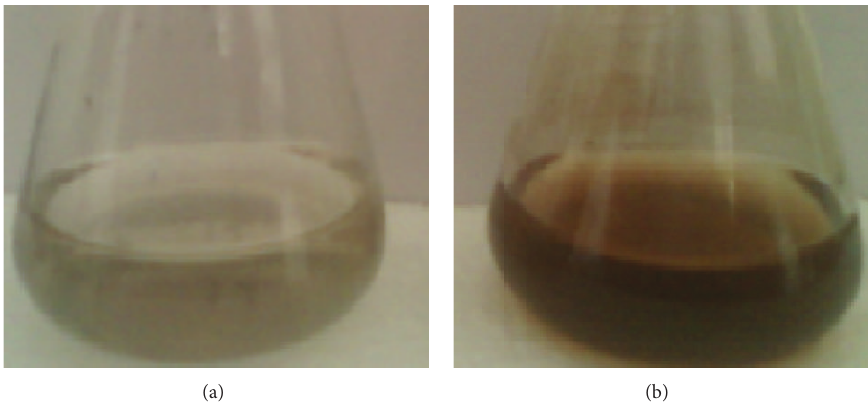
Figure 1: Optical photographs represent the synthesis of silver ions. (a) Control (cyanobacterial cell filtrate without treatment); (b) cyanobacterial cell filtrate treated with 1mM silver nitrate.